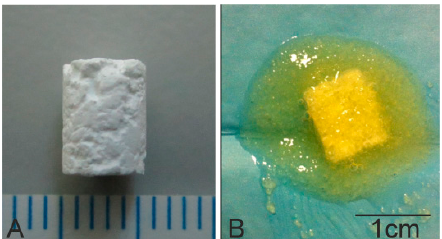
Figure 1. Photographs of the ( A ) calcium silicophosphate (CSP) scaffold and ( B ) the demineralized bone matrix (DBM)-coated scaffold.